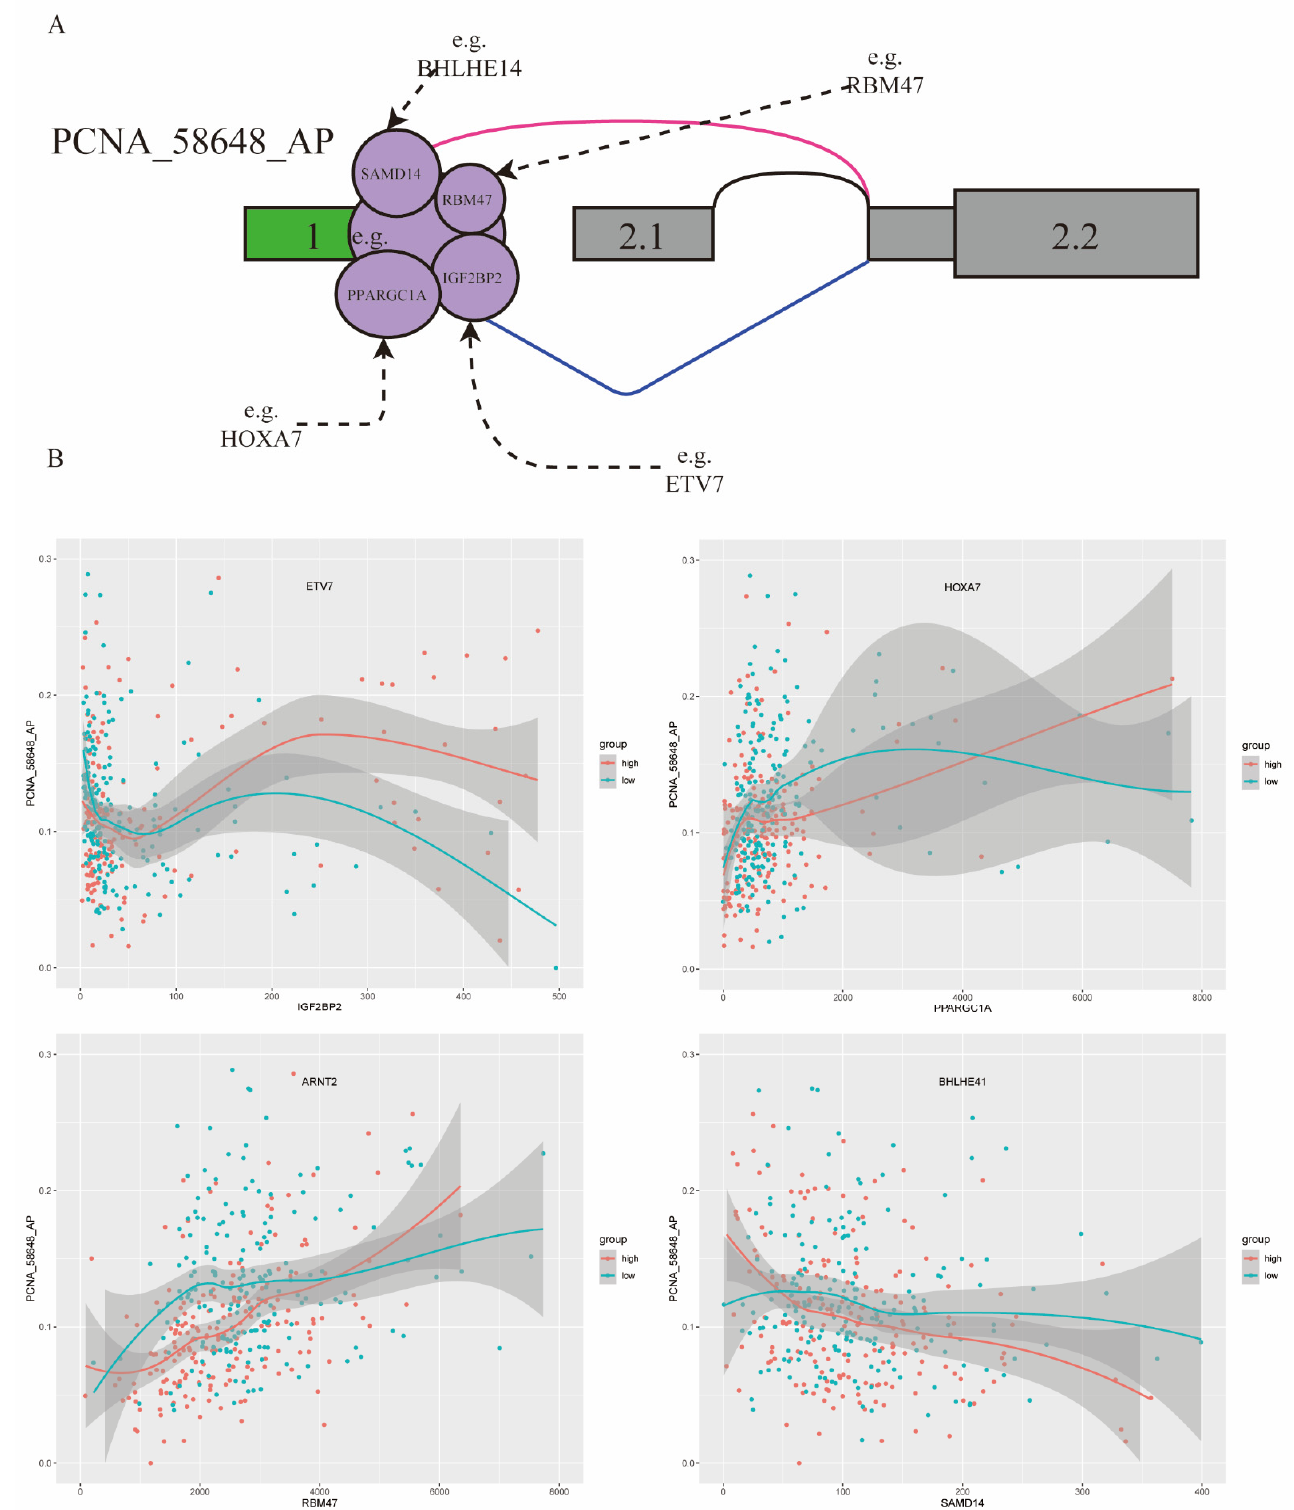
Figure 5. PCNA_58648_AP influenced by TFs and RBPs involved in triplets in KIRC. ( A ) Examples of some TFs and RBPs involved in triplets. ( B ) Four triplets influencing splicing of PCNA_58648_AP: four TFs (ETV7, HOXA7, ARNT2, BHLHE41) and four RBPs (IGF2BP2, PPARGC1A, RBM47, SAMD14). Red, samples in high TF expression group (top 40%); green, samples in low TF expression group (bottom 40%). X axis is the expression level of RBP, and Y axis is the PSI value of PCNA_58648_AP .